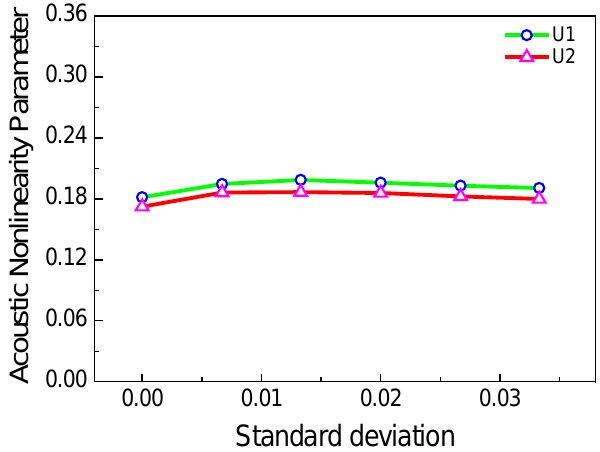
Figure 11. Acoustic nonlinearity parameter versus standard deviation of micro-crack lengths with Gaussian distribution ( c = 0.1, f = 1000 kHz, µ = 0.1, w % = 100%).